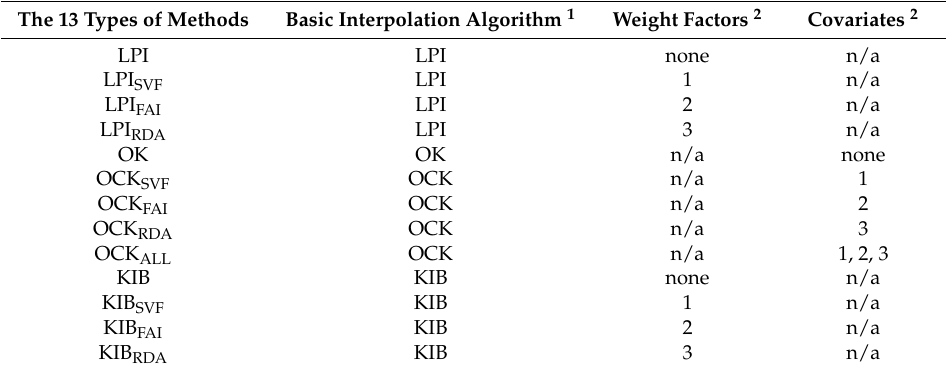
Table 1. List of the 13 types of spatial interpolation methods used in this